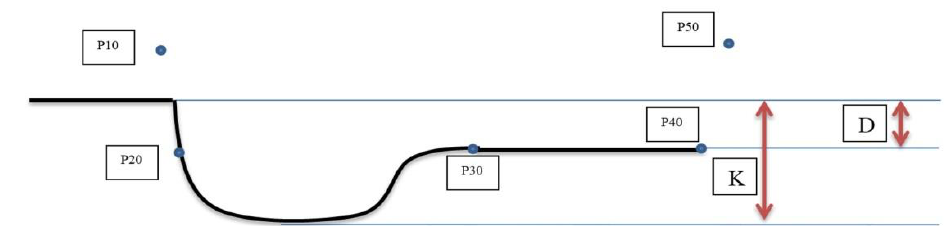
Figure 9. Characteristic points of the robot ’ s path.